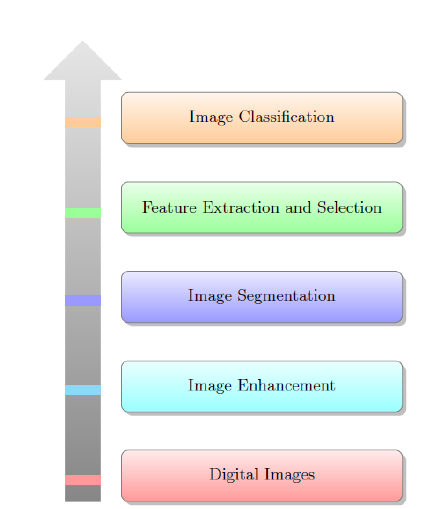
Figure 1. A simple block diagram for breast cancer detection